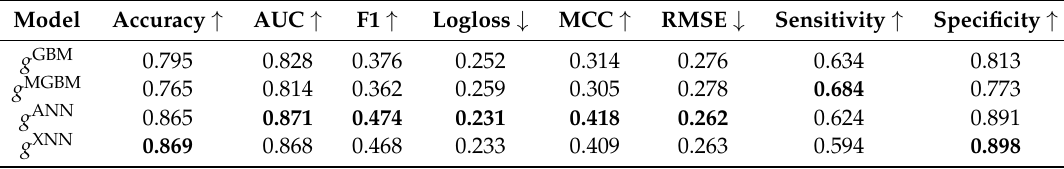
Table 2. Fit measures for g GBM ( X ) , g MGBM ( X ) , g ANN ( X ) , and g XNN ( X ) on the mortgage test data. Arrows indicate the direction of improvement for each measure and the best result in each column is displayed in bold